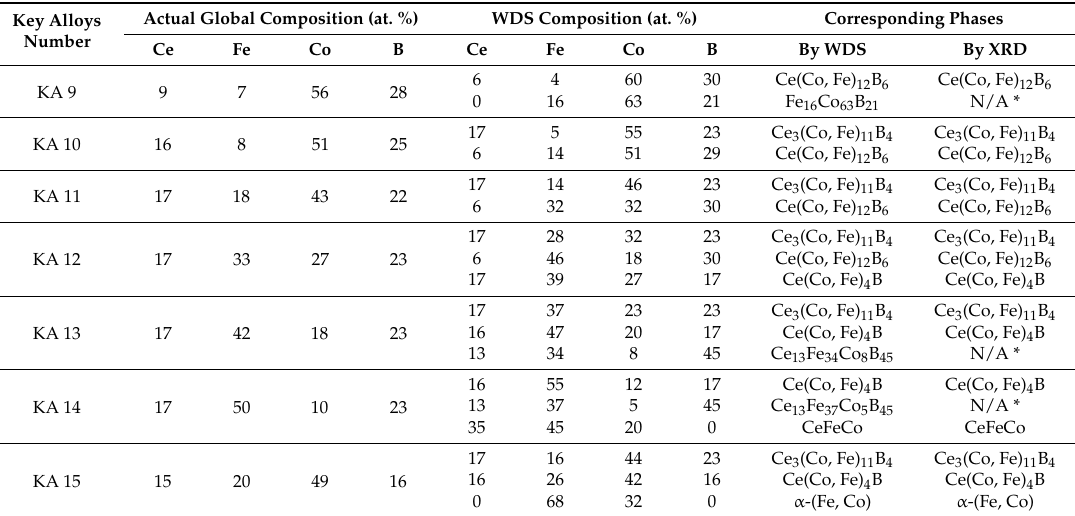
Table 3. Chemical composition of key alloys and detected